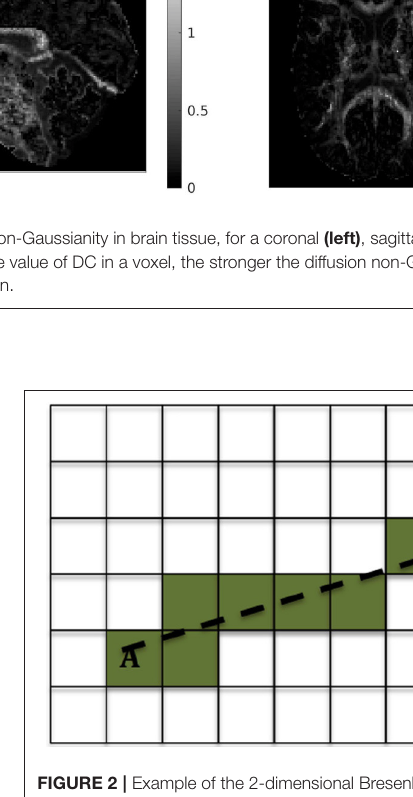
FIGURE 2 | Example of the 2-dimensional Bresenham algorithm (50) for identifying the squares for the line that connects square A to square B. The shaded squares are the ones